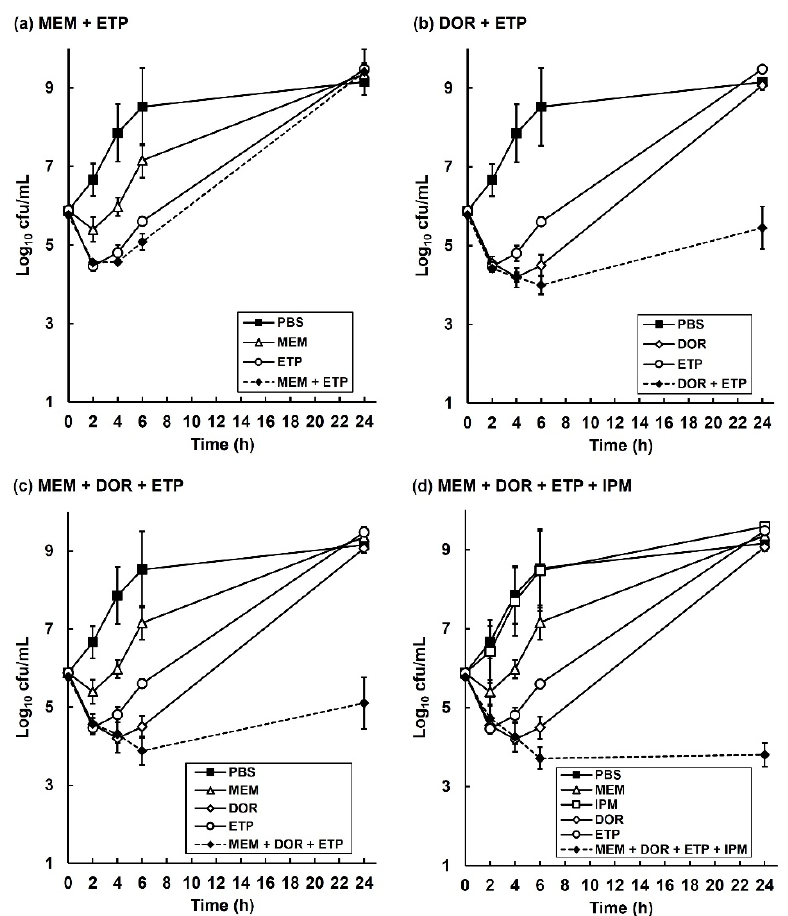
Figure 4. Time-kill assays comparing the effect of exposure to single carbapenems with carbapenem combinations on the growth and viability of P. aeruginosa NCTC13437 in vitro. Bacteria were exposed to carbapenem concentrations at MIC 0 . 5 for 24 h at 37 °C in MHB. Combinations tested were: a) MEM (32 mg/L) + ETP (128 mg/L); b) DOR (32 mg/L) + ETP (128 mg/L); c) MEM (32 mg/L) + DOR (32 mg/L) + ETP (128 mg/L); d) MEM (32 mg/L) + DOR (32 mg/L) + ETP (128 mg/L) + IPM (256 mg/L).